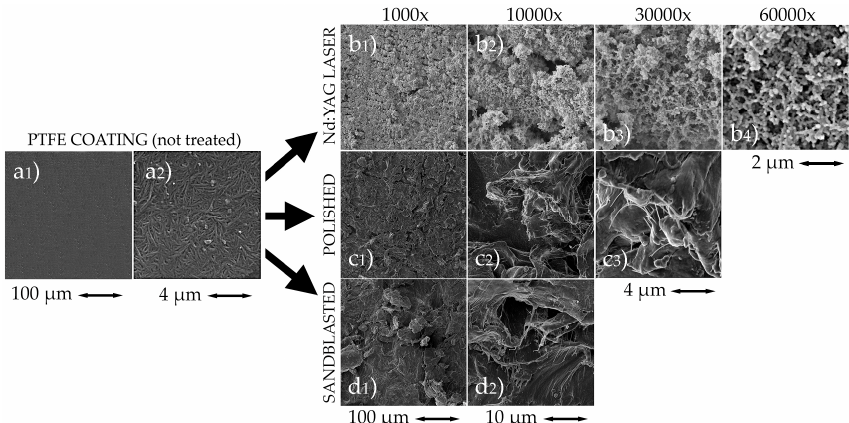
Figure 2. ESEM images of the fluoropolymer coatings after each surface treatment: ( a ) as-received coating showing the small size of the fibers; ( b ) laser ablated coating (fluence 260.4 J/cm 2 and beam speed of 100 mm/s); ( c ) polished coating (P500 grit cured at 395 °C); and ( d ) sandblasted coating (brown corundum ejected at 0.1 MPa for 40 s).